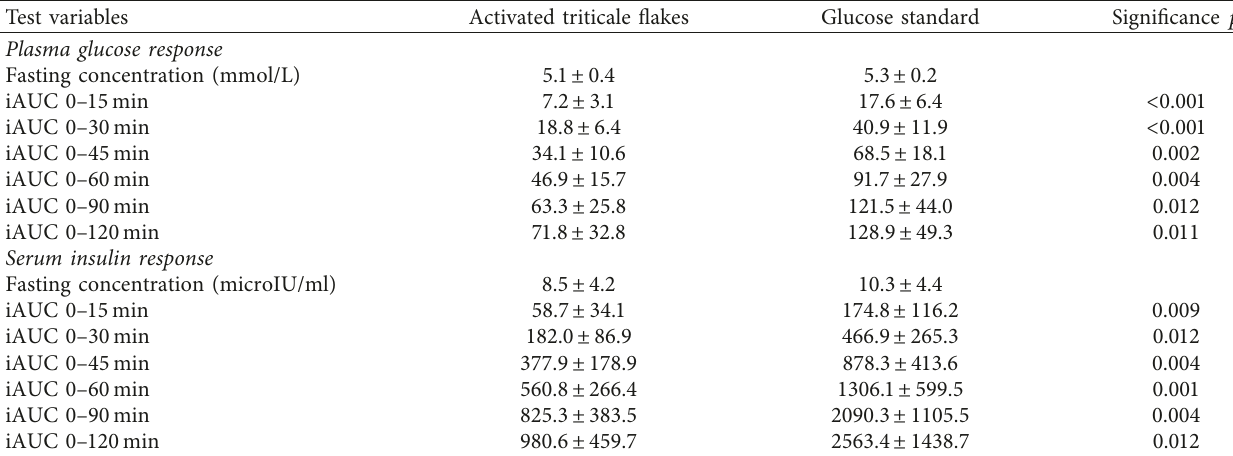
Table 3: Plasma glucose response, expressed as iAUC (in mmol ∗ min/L), and serum insulin response, expressed as iAUC (in microIU ∗ min/ mL) after a meal of activated triticale flakes or a glucose